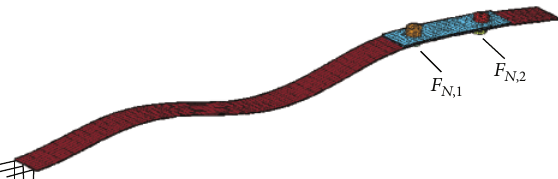
Figure 3: Finite-element model ( ≈ 30000 DOFs and 632 nodes in contact) in typical bending deformation with the two screws that impose the external clamping force pairs 𝐹 𝑁,1 and 𝐹 𝑁,2